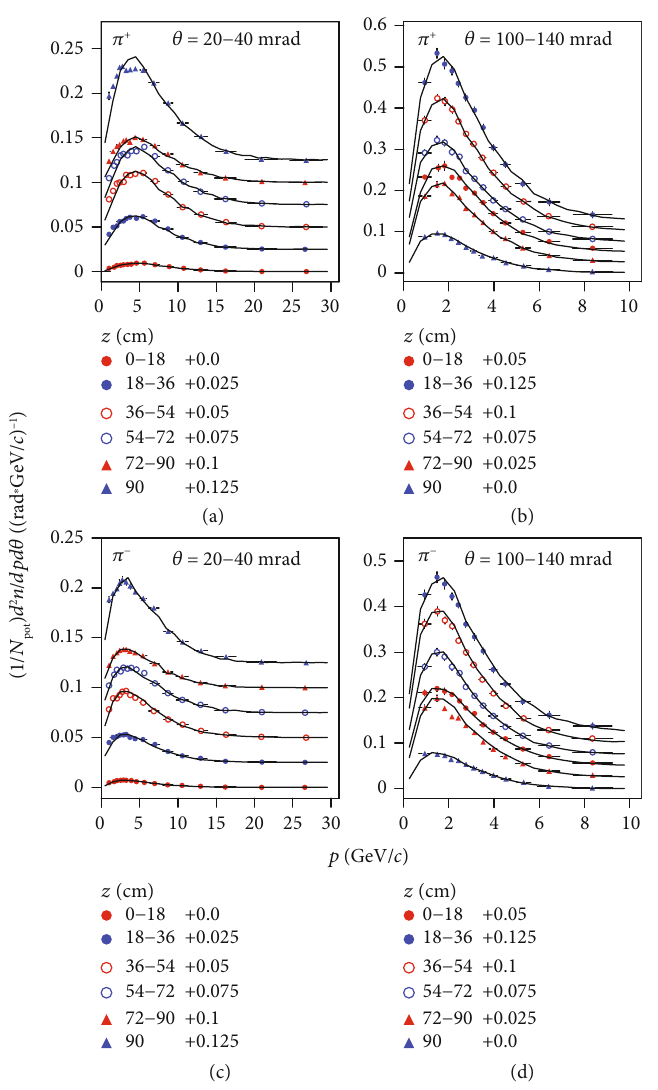
Figure 3: Same as Figure 1 but showing the spectra of (a – b) π + and (c – d) π − in (a – c) θ = 20 – 40mrad and (b – d) θ = 100 – 140mrad in six z